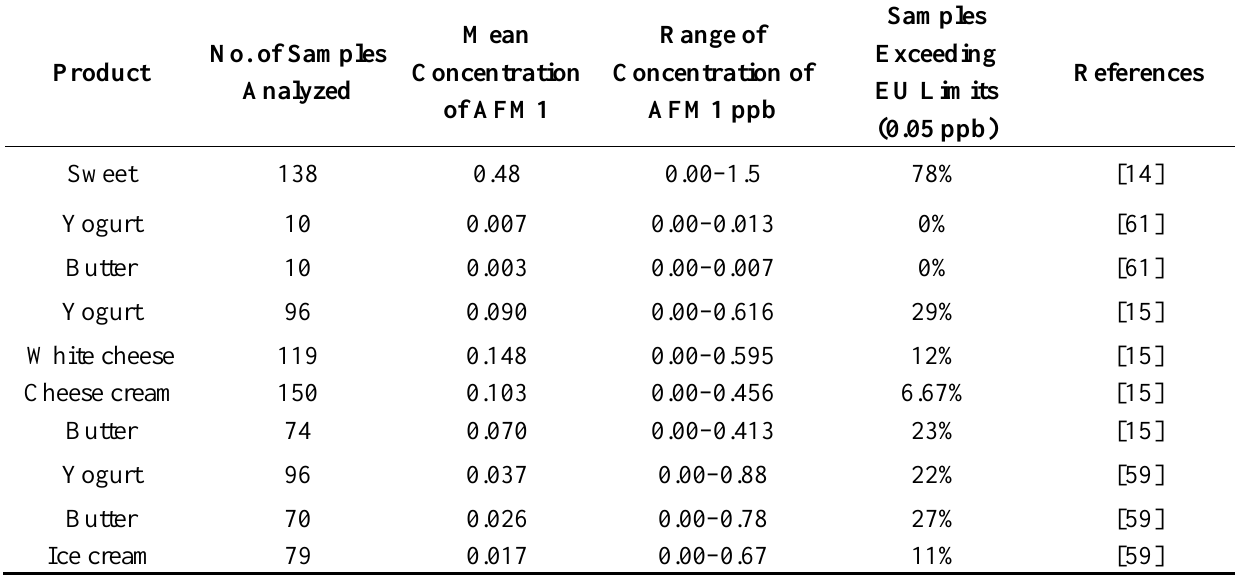
Table 3. Studies reporting the presence of aflatoxin M1 in milk products in